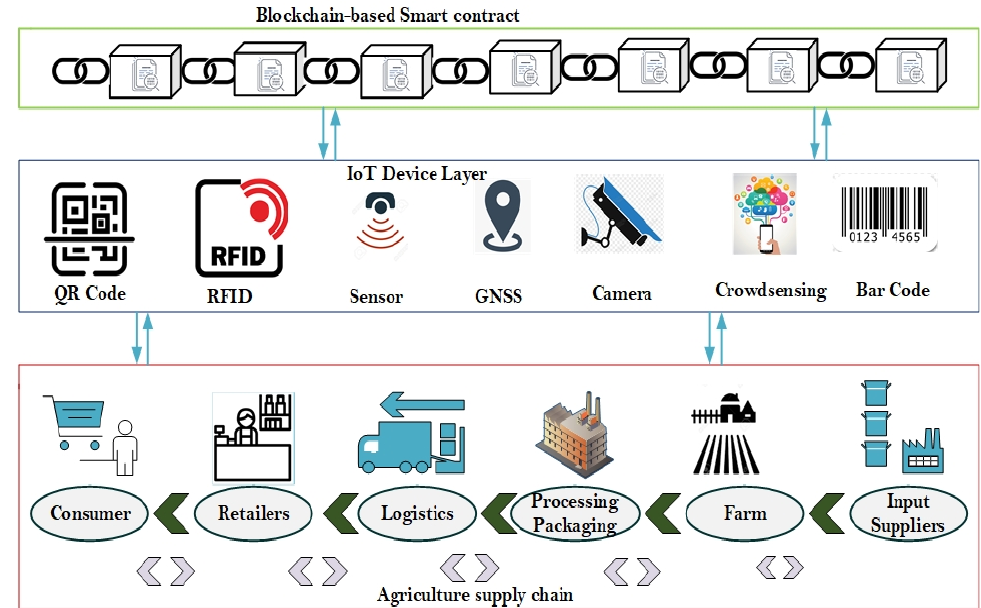
Figure 3. Blockchain-based smart agri-supply chain .